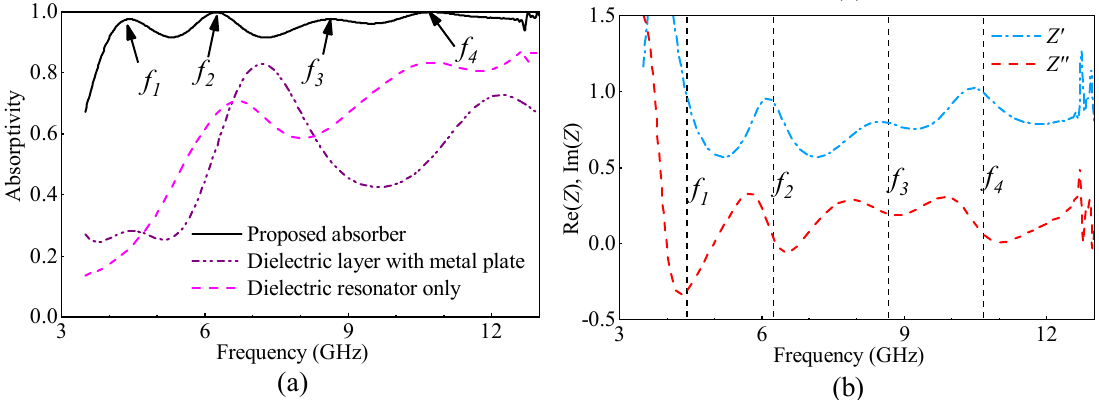
Figure 3. ( a ) Simulated absorption spectra of the designed dielectric ‐ resonator ‐ based absorber. The simulated results for the two comparison cases, namely, the dielectric plate with the metal back and the dielectric resonator without the metal back, are also plotted. The four absorption peaks of the designed absorber are marked as f 1 , f 2 , f 3 , and f 4 in the figure; ( b ) Simulated input impedance of the designed dielectric ‐ resonator ‐ based absorber, with the four absorption peaks marked.